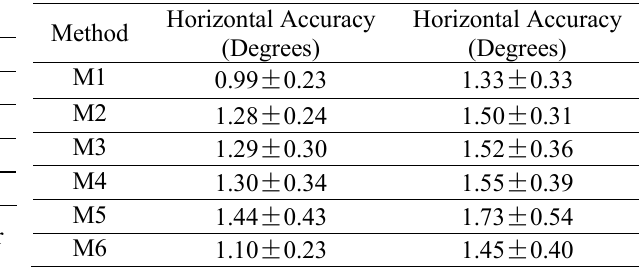
Table 4 Compared globe average accuracy in horizontal and vertical directions obtained by our method with